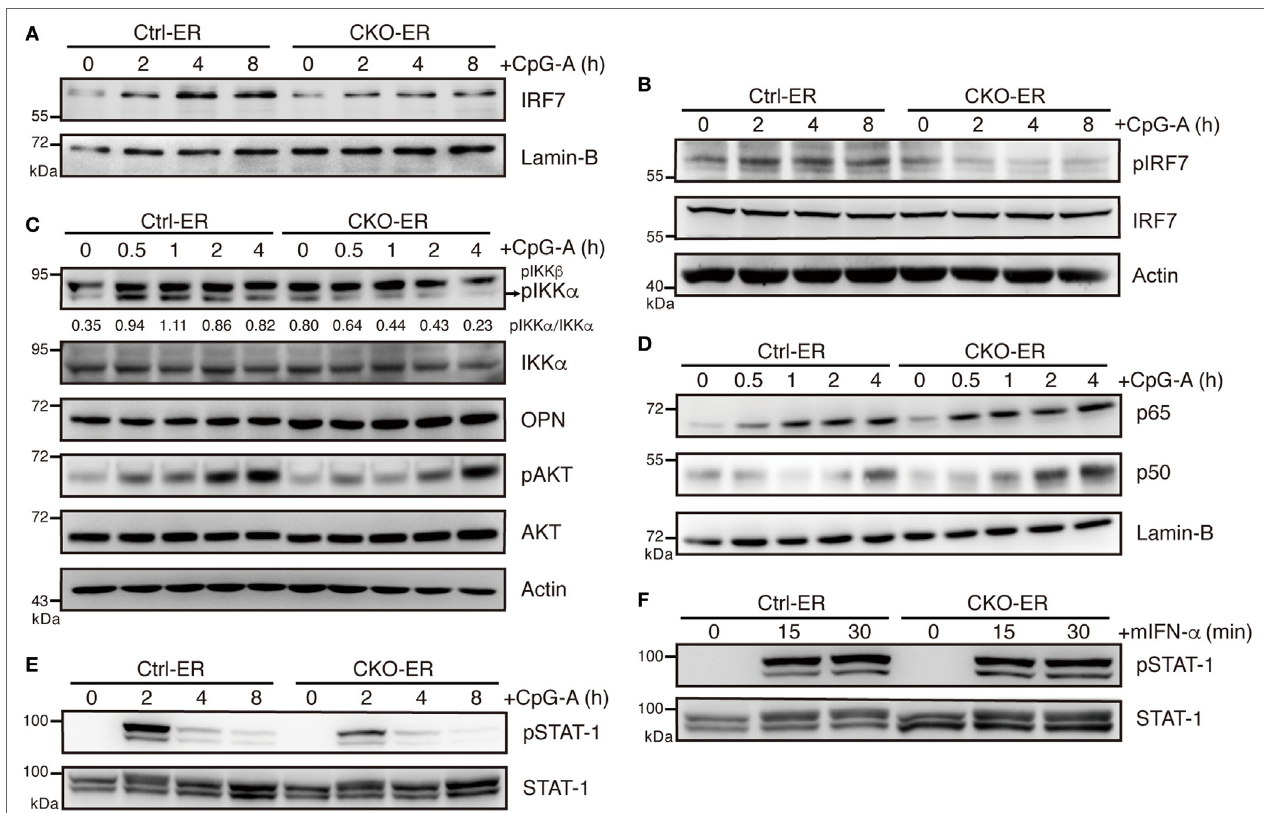
FigUre 7 | Impaired IKK α and IRF7 activation in plasmacytoid dendritic cells (pDCs) with reduced Blimp-1 expression. (a) Immunoblot analysis of nuclear extracts showing the levels of IRF7 in 4-OHT treated Ctrl-ER and CKO-ER FLpDCs following stimulation with 1 µM CpG-A at indicated time points. (B) Immunoblot analysis of total cell lysates showing the levels of IRF7 phosphorylation at Ser471/472 in 1 µM CpG-A stimulated Ctrl-ER and CKO-ER FLpDCs. (c) Immunoblot analysis showing the levels of phospho-IKK α at Ser176/180, OPN and phospho-AKT at Ser473, in 4-OHT treated and CpG-A stimulated Ctrl-ER and CKO-ER FLpDCs. The quantification of pIKK α was presented by the ratios of pIKK α band intensity vs. IKK α band intensity at each time point. (D) Immunoblot analysis using nuclear extracts of 4-OHT treated Ctrl-ER and CKO-ER FLpDCs showing the levels of p50 and p65 translocation after 1 µM CpG-A treatment at indicated time points. (e) Immunoblot analysis showing the levels of phosphorylated STAT1 at Tyr701 at the indicated time points in Ctrl-ER and CKO-ER FLpDCs treated with 4-OHT and then stimulated with 1 µM CpG-A at the indicated time points. (F) Immunoblot analysis showing levels of phosphorylated STAT1 at Tyr701 in FLpDCs in the presence of 500 U/ml mIFN- α